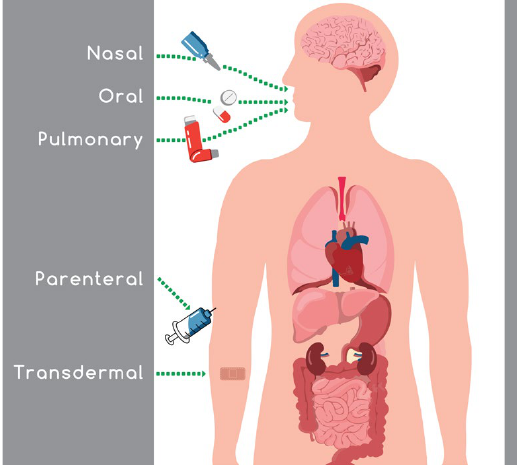
Figure 1. Different routes of drug administration.